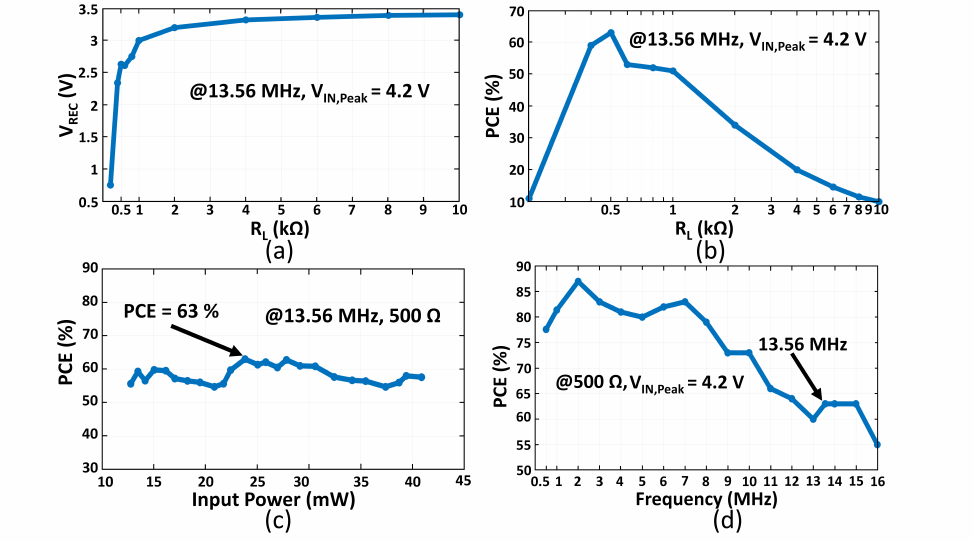
Figure 13. Rectifier measurement results ( a ) V REC versus R L , ( b ) PCE versus R L , ( c ) PCE versus input power, ( d ) PCE versus